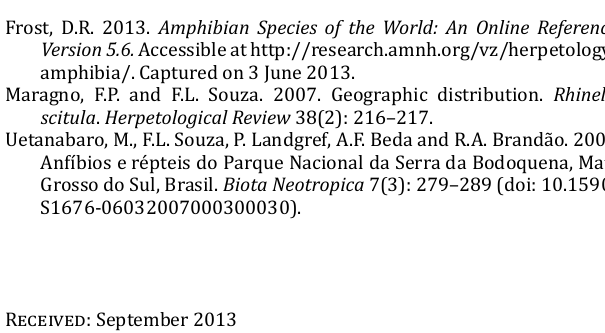
Rhinella scitula distribution